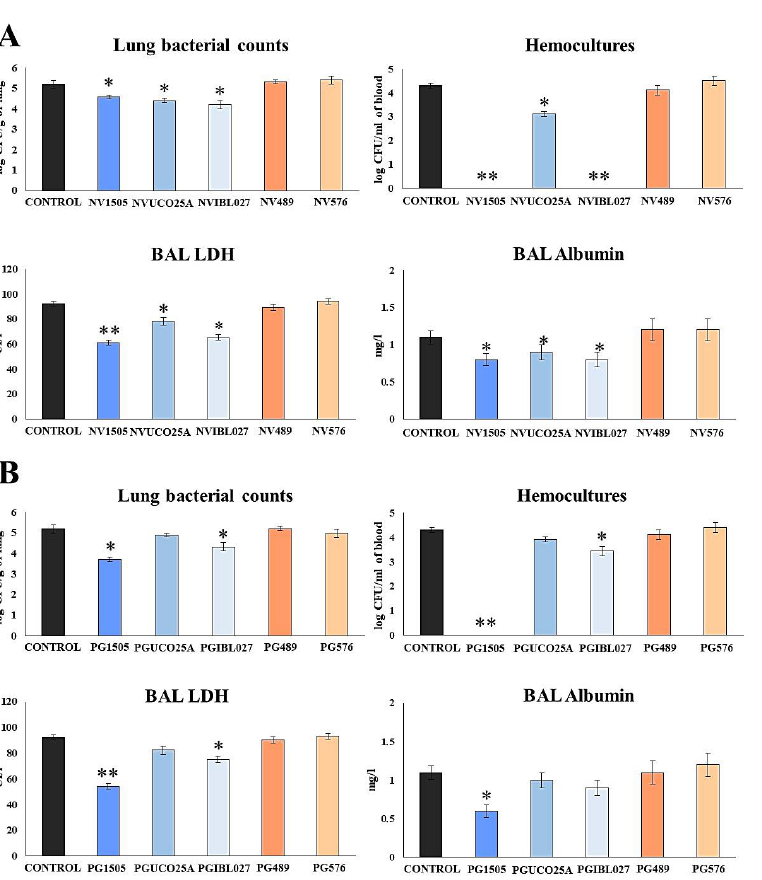
Figure 1. ( A ) Ability of nonviable (NV) L. rhamnosus CRL1505, CRL498, CRL576, UCO25A and IBL027 and ( B ) their peptidoglycans (PGs) to improve the resistance to secondary pneumococcal pneumonia after poly(I:C) treatment. Infant mice were nasally primed with NVs or PGs during two consecutive days, then stimulated with three once-daily doses of poly(I:C) and finally challenged with S. pneumoniae serotype 6B five days after the last administration of poly(I:C). Non-treated infant mice stimulated with poly(I:C) and then challenged with S. pneumoniae were used as controls. Lung bacte- rial cells counts, hemocultures, lactate dehydrogenase (LDH) activity and albumin concentrations in bronchoalveolar lavages (BAL) were determined on day 2 post-pneumococcal challenge. Asterisks indicate significant differences between treated and control groups; * ( p < 0.05) and ** ( p <